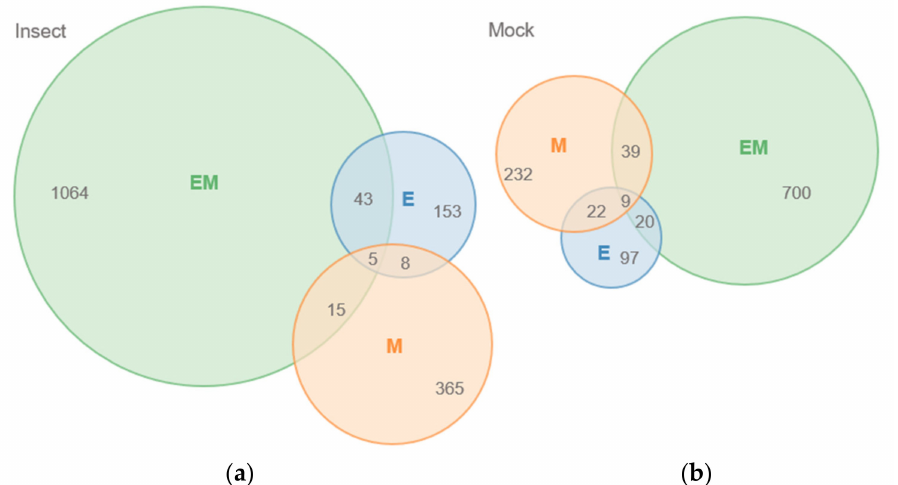
Figure 1. Venn diagrams of the number of MS peaks from soybean QTLs that are significantly different in intensity from insect-susceptible parent Benning. ( a ) Treatment with soybean looper for 72 h. ( b ) No insect